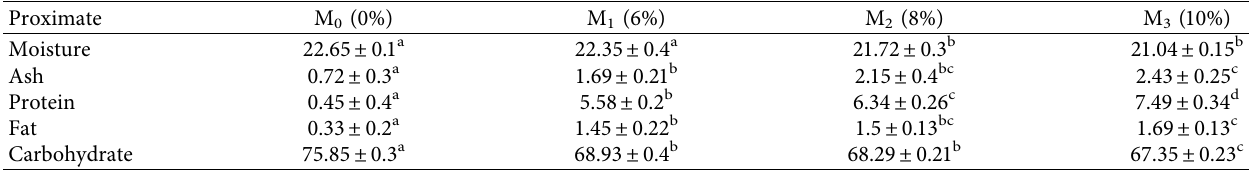
Table 3: The results of proximate analysis of sago noodles fortified with Biang fish meal. Proximate